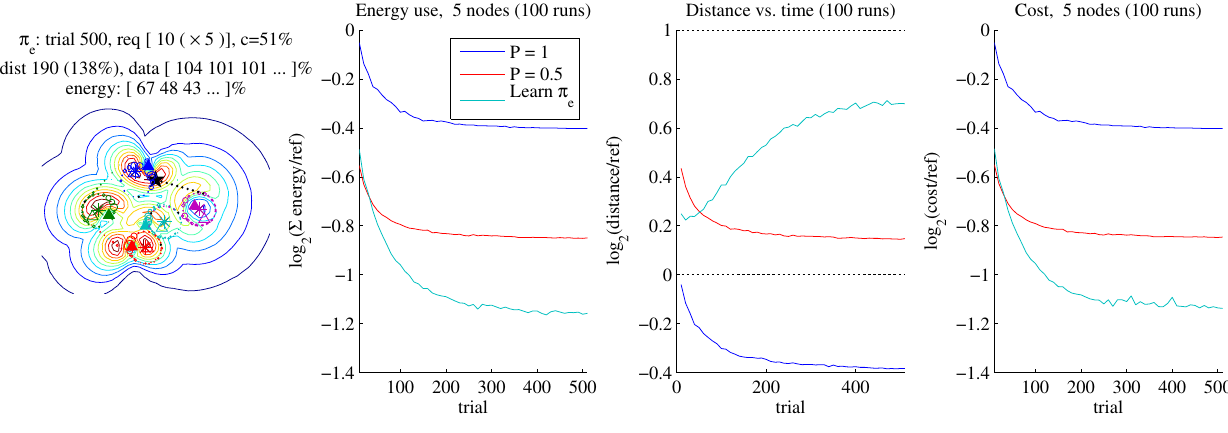
Figure 12. Energy optimisation with a square deployment in which the UA is misinformed about sensor location by 3 units in a random direction. Other configurations and descriptions are the same as in Figure